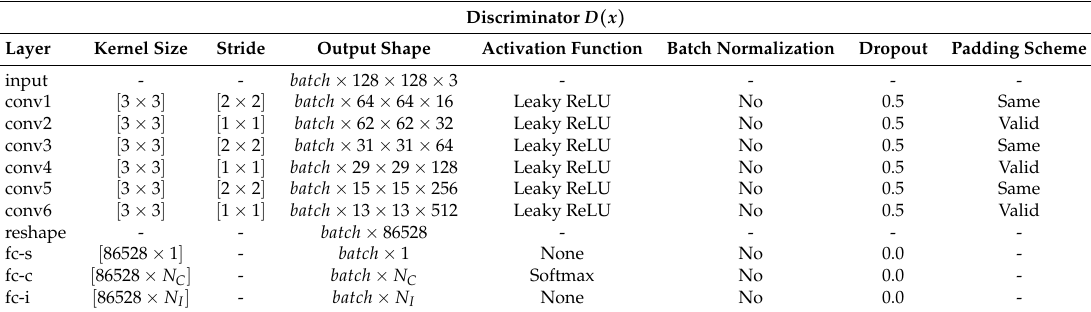
Table A1. Discriminator network architecture details.